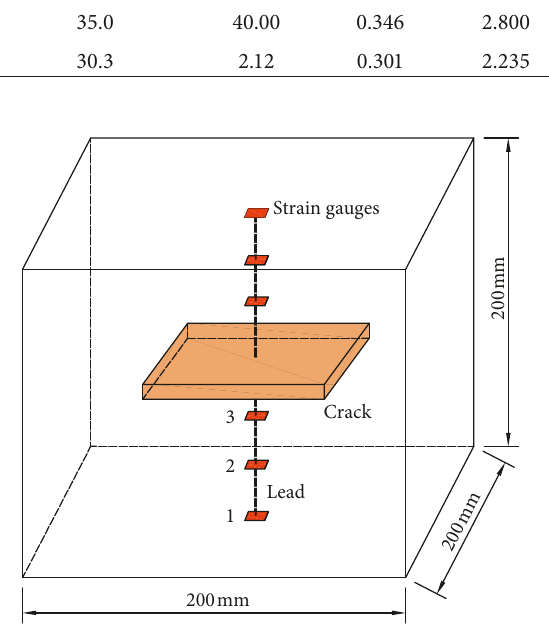
Figure 5: Relative positions of measuring points and